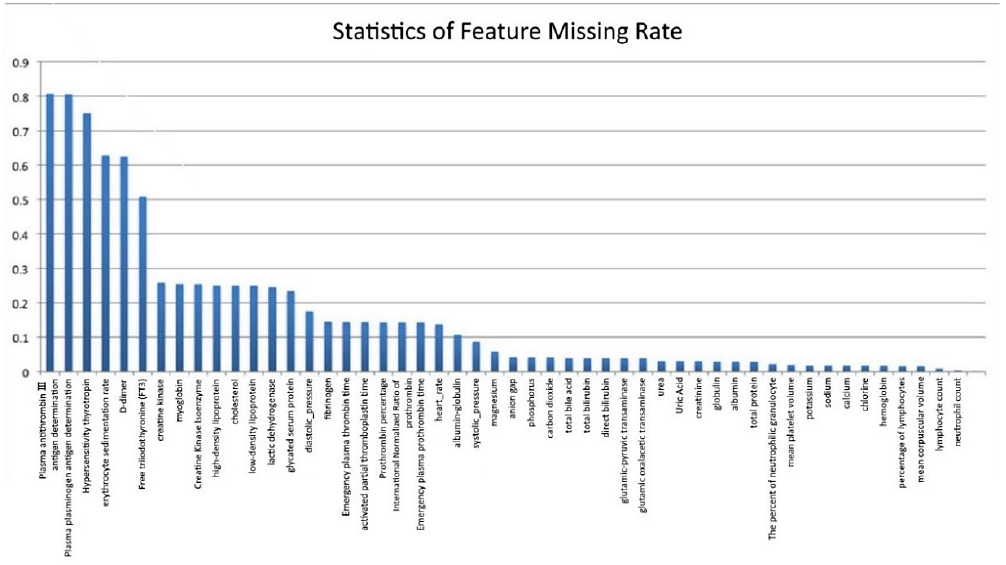
Figure 3. Feature Missing Rate Statistics.